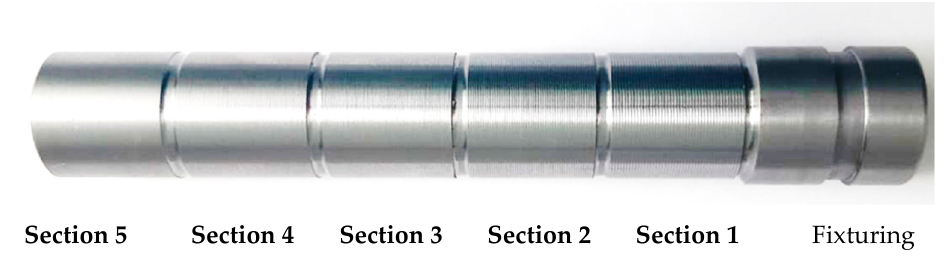
Figure 1. Processed parts.